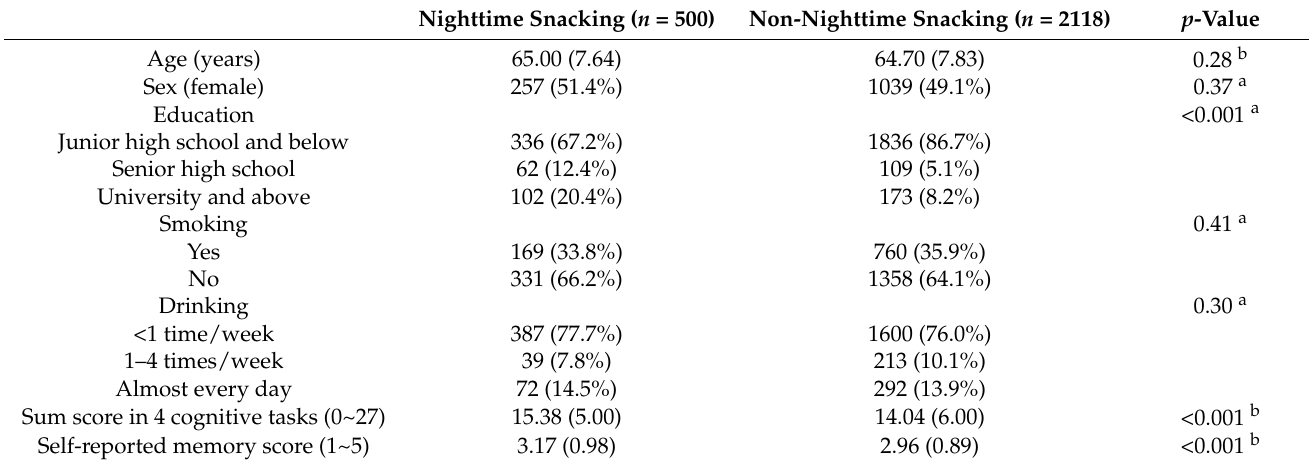
Table 1. Nighttime snacking versus non-nighttime